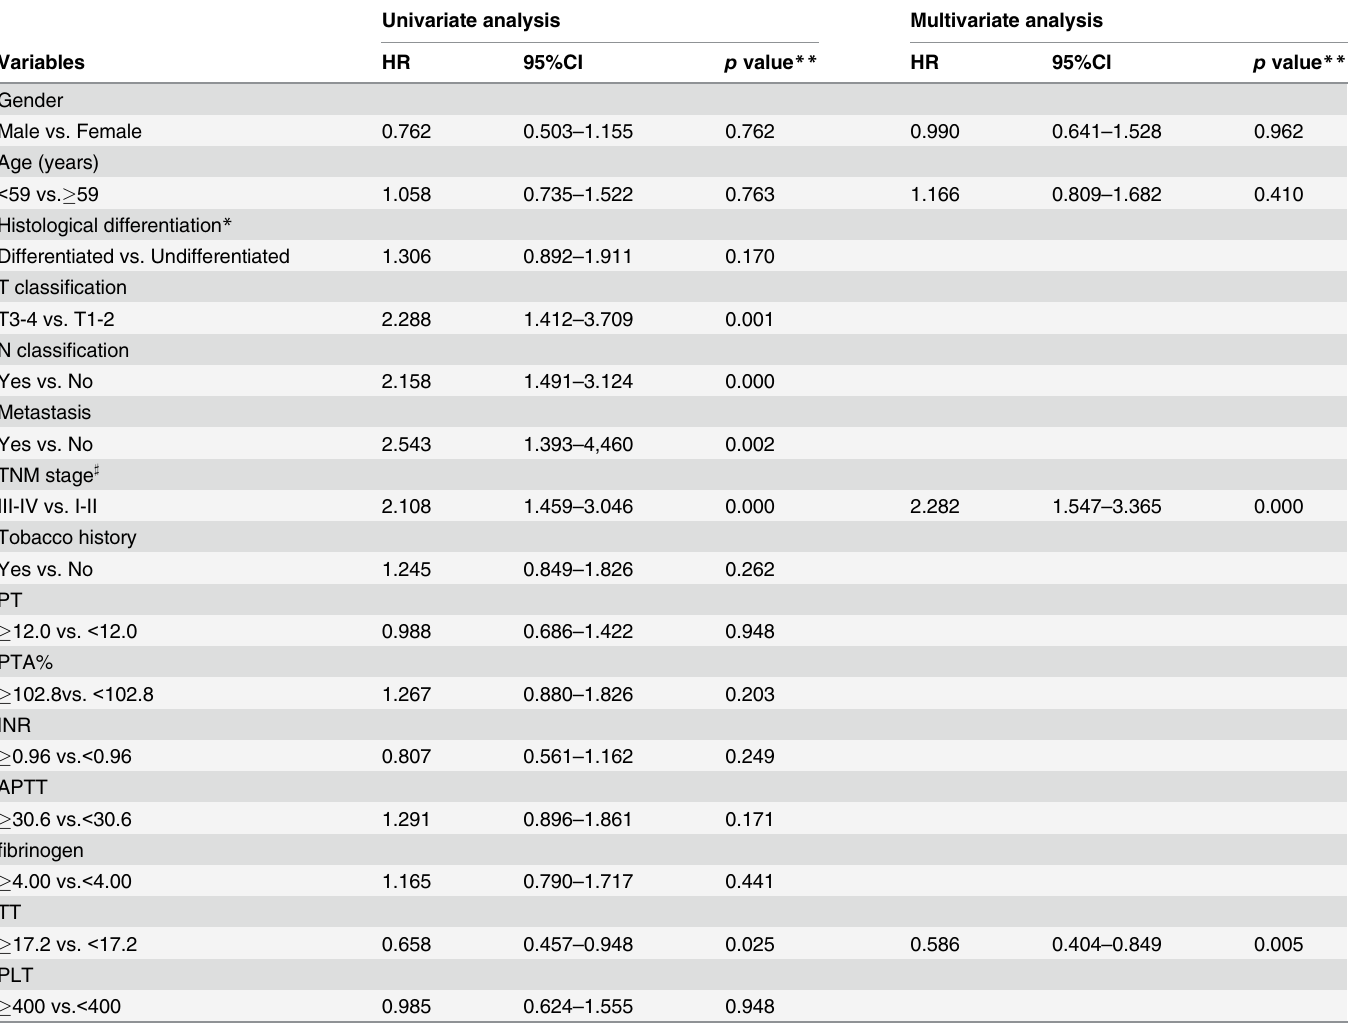
Table 3. Univariate and multivariate cox hazards analysis for overall survival in 204 patients with